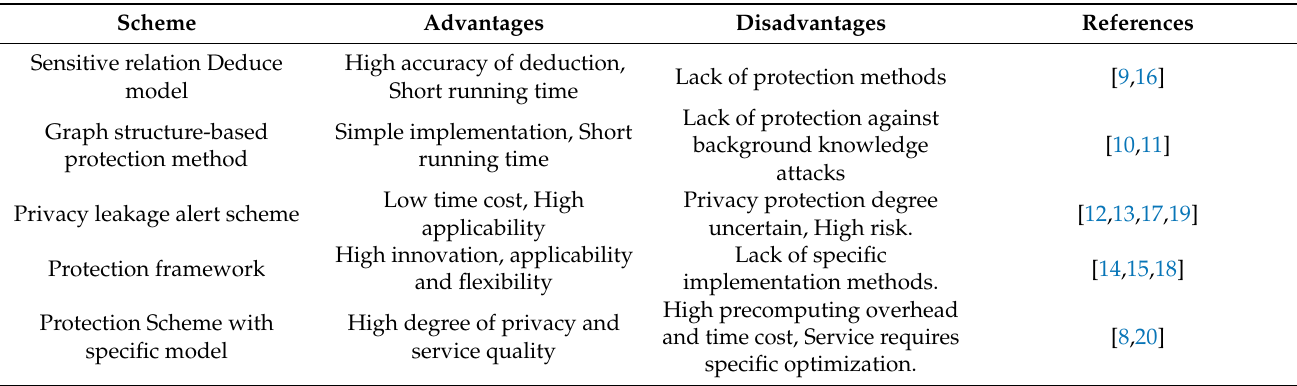
Table 1. State-of-the-art